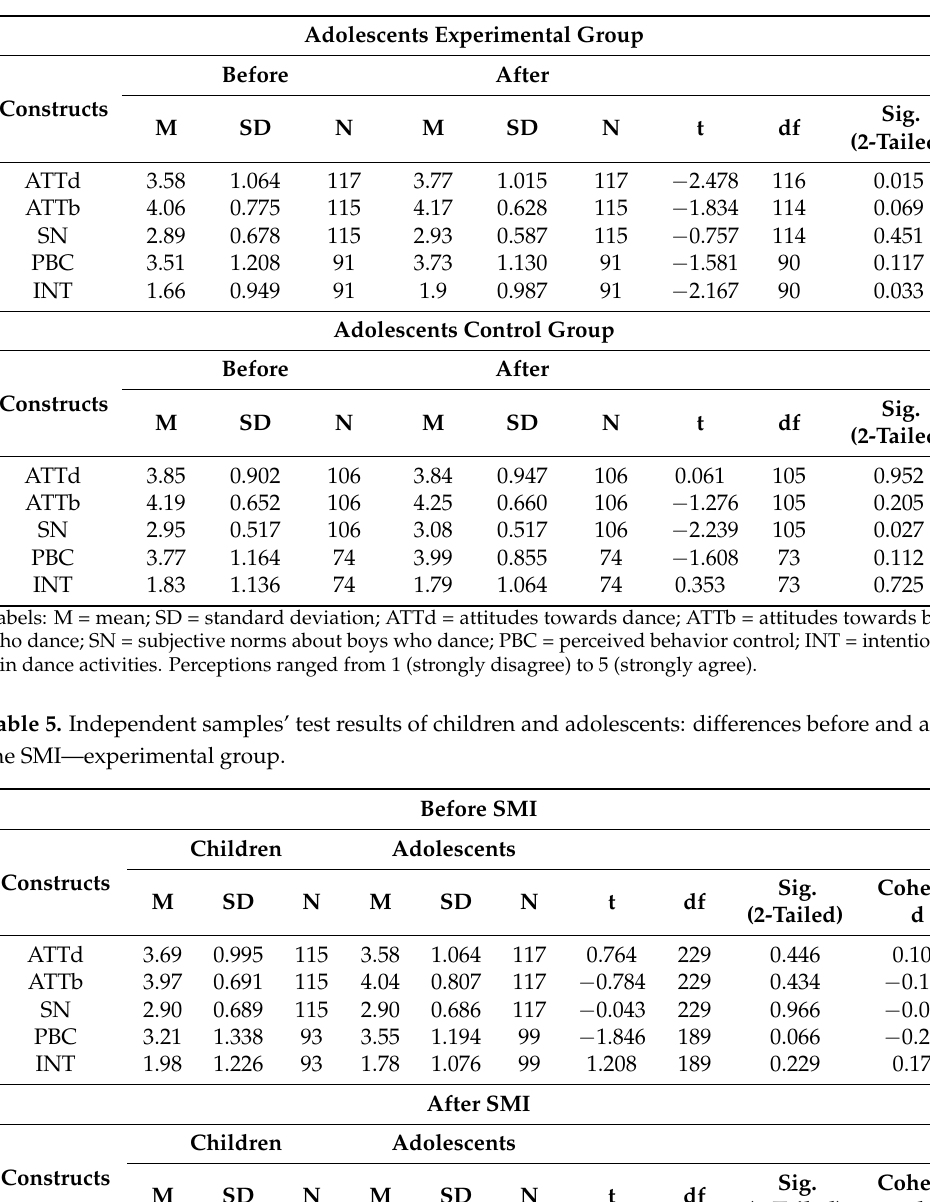
Table 4. Paired samples’ test results of children and adolescents: differences before and after the SMI—adolescents.